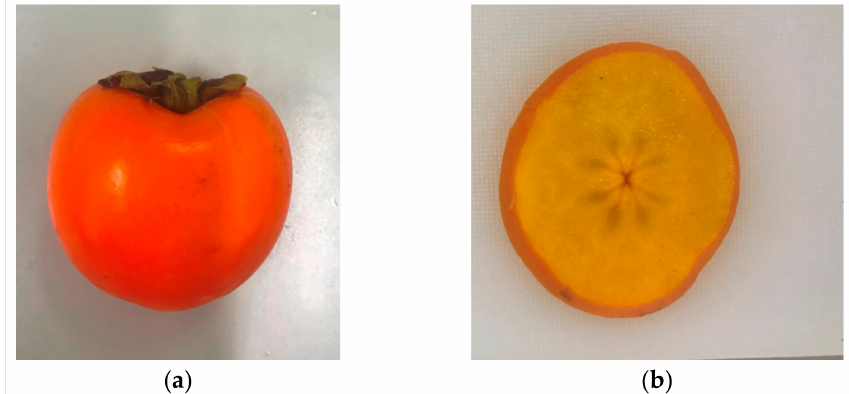
Figure 1. ( a ) Whole persimmon fruit, cv. “Rojo Brillante”; ( b ) Internal view of the persimmon fruit, cv. “Rojo